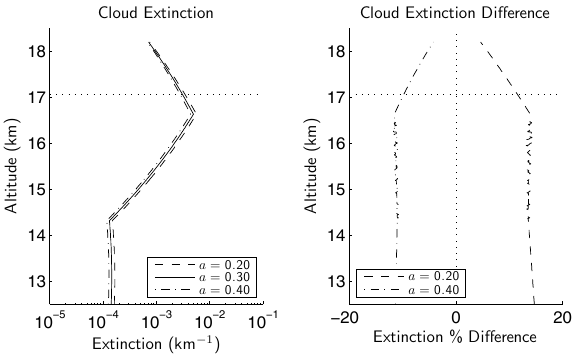
Fig. 15: Retrieved cirrus extinction for varying assumed par- ticle size, scan 47626029.